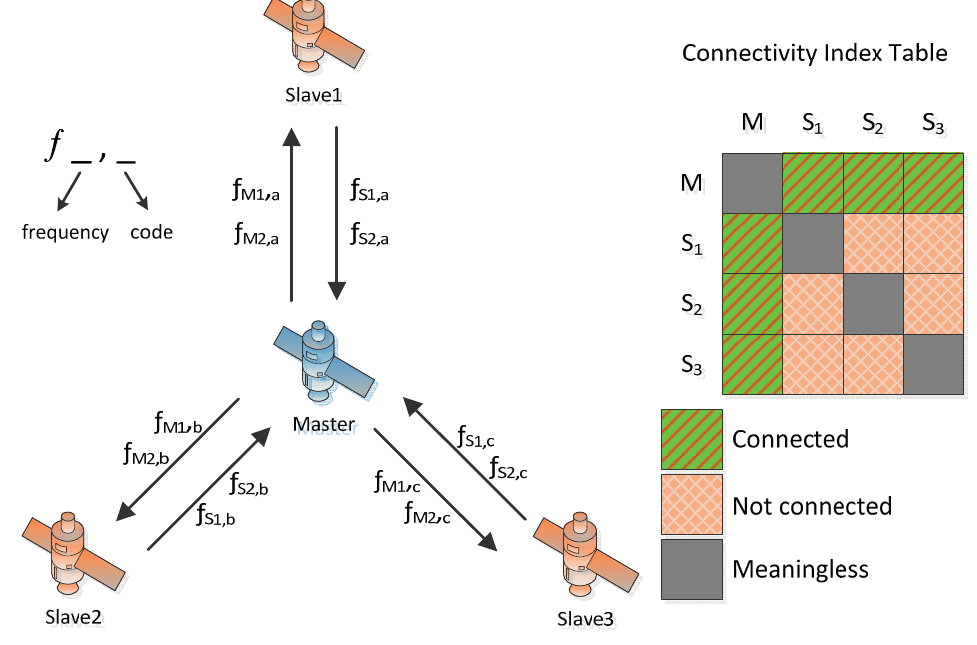
Figure 1. An example of connectivity with three slave satellites and a master